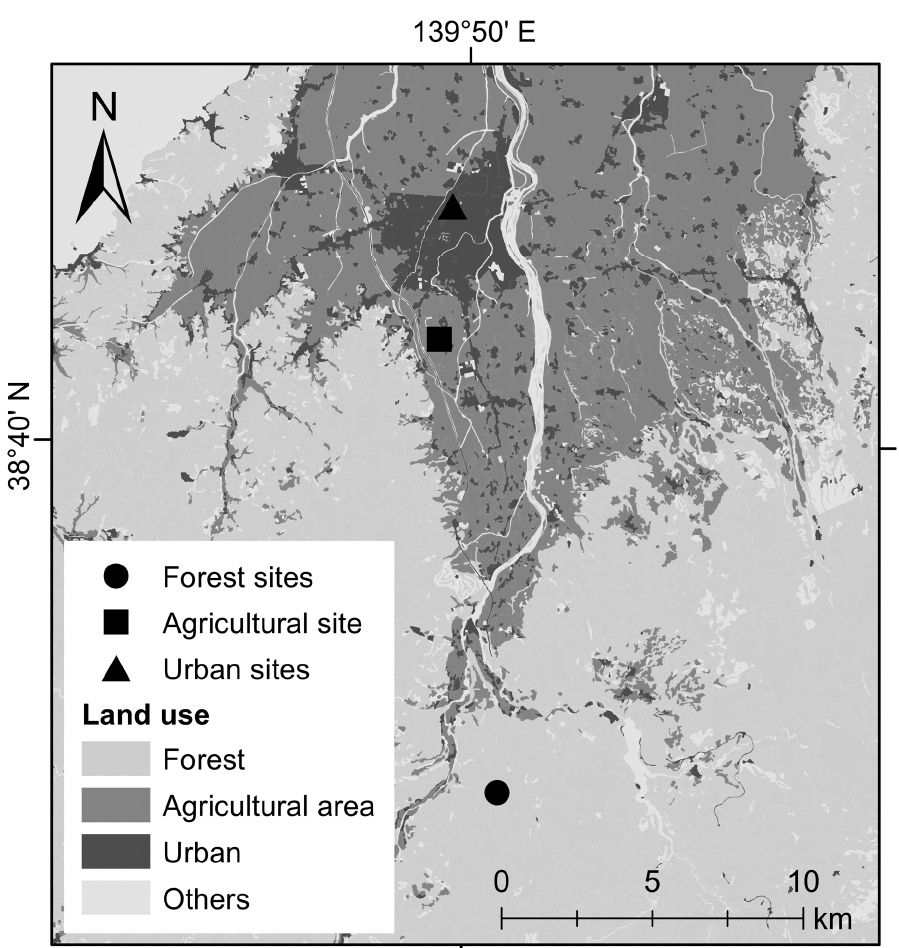
Figure 1. Locations of the study area and the sites that were surveyed.